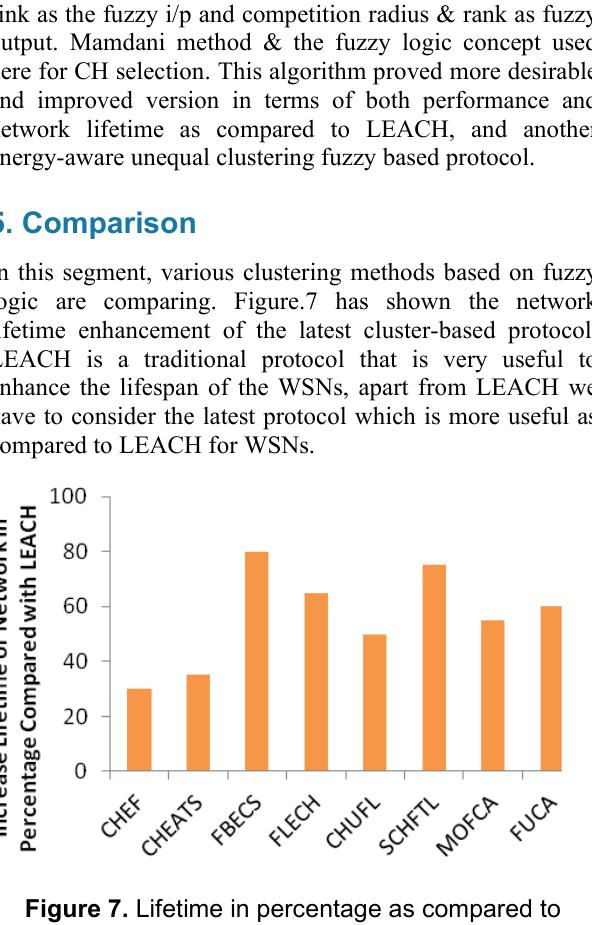
Figure 7. Lifetime in percentage as compared to various